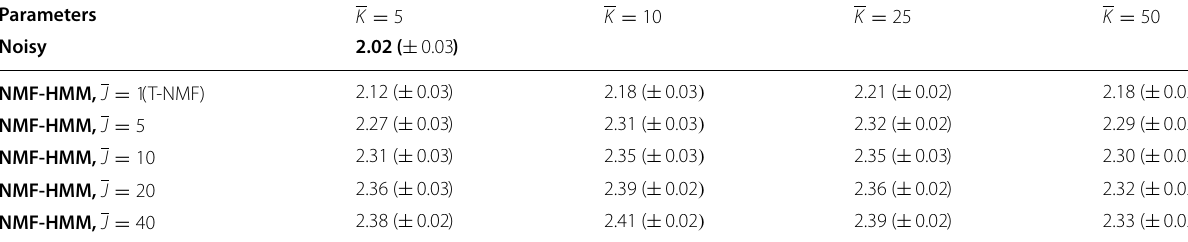
Table 2 Average PESQ scores (%) comparisons of different clean speech states and basis vectors ( ¨ J = 1, ¨ K = 70 ) Parameters K = 5